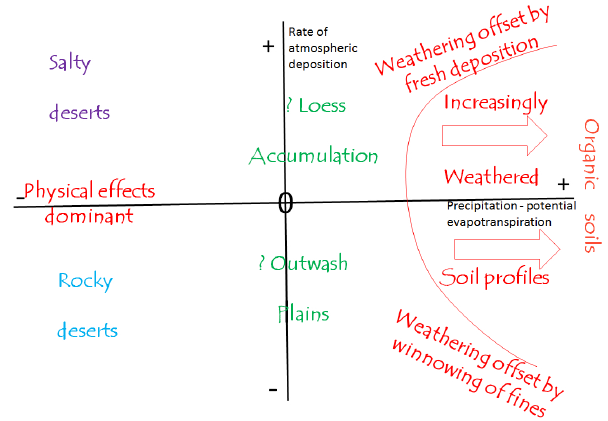
Figure 2. Broad typology of soil types, controlled by net atmo- spheric inputs (e.g. salt and dust) and net water balance (precipita- tion minus